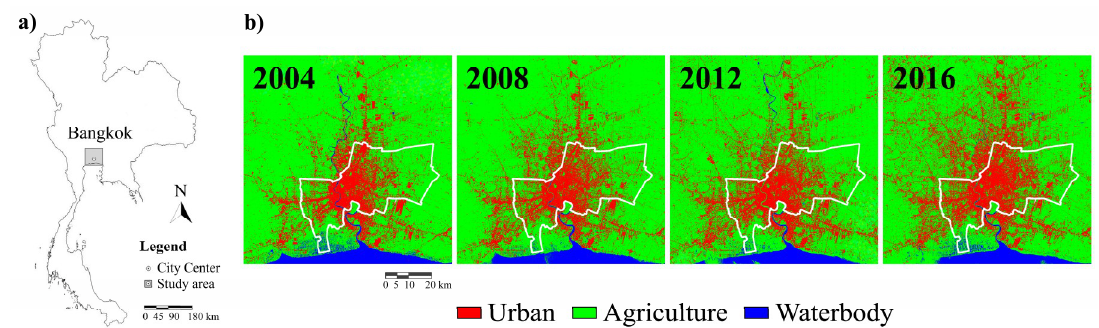
Figure 1. ( a ) Bangkok position in Thailand (city center coordinates: latitude 13°45′7″N, longitude 100°31′48″E). ( b ) Land Use and Land Cover (LULC) map of Bangkok (90 km × 90 km) obtained from Landsat data for 2004, 2008, 2012, and 2016 (see Section 3.1). The white line is the Bangkok administrative boundary.